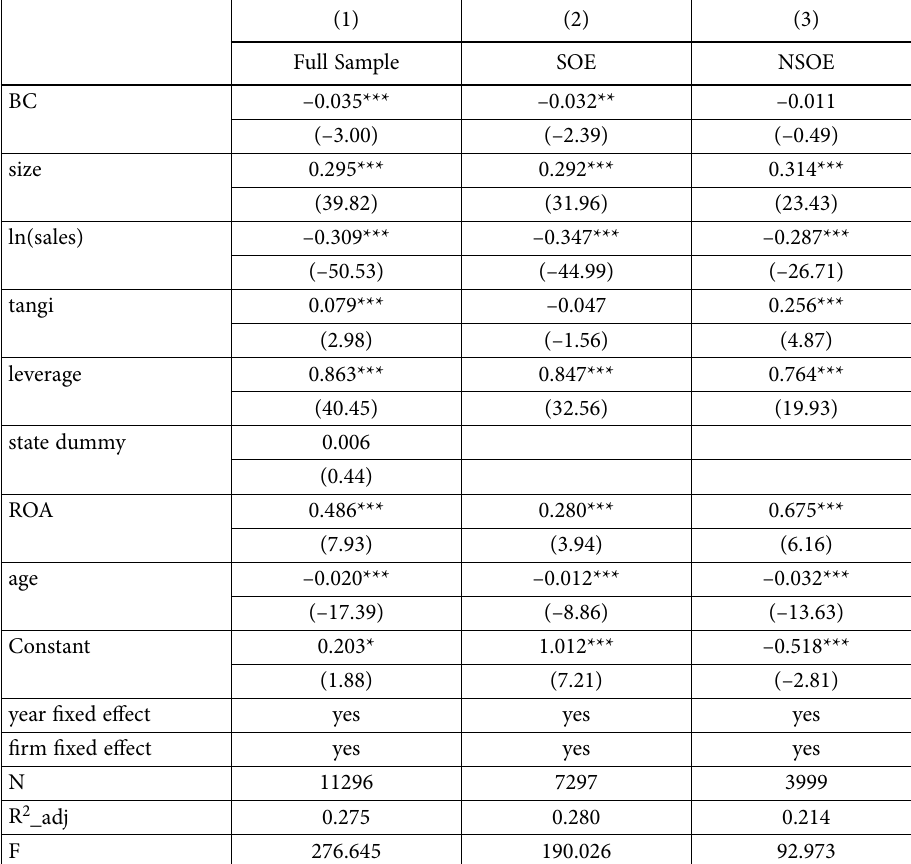
Table 2. Relationship between bank connections and short-term